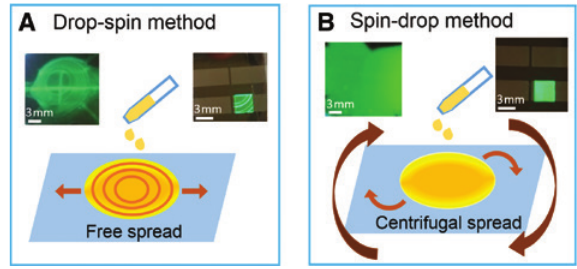
Figure 1: Schematic diagrams illustrating the quality of the CsPbBr 3 thin films prepared by (A) drop-spin and (B) spin-drop methods. The inserts in (A): the photo pictures taken for the CsPbBr thin 3 film grown on PEDOT:PSS/ITO exposed under UV light (left) and a bi-functional diode emitting light at 3 V (right). The inserts in (B): the photo pictures taken for the CsPbBr thin film grown on PEDOT:PSS/ 3 ITO exposed under UV light (left) and a bi-functional diode emitting a uniform light at 3 V